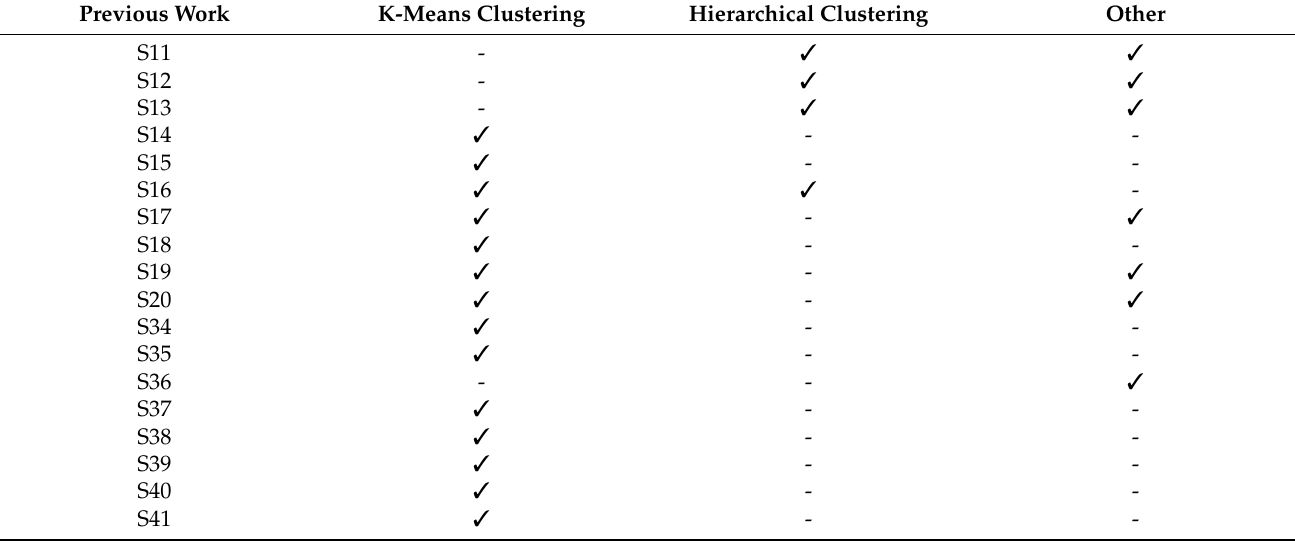
Table A2. Major factors of clustering and classification techniques of energy consumption of